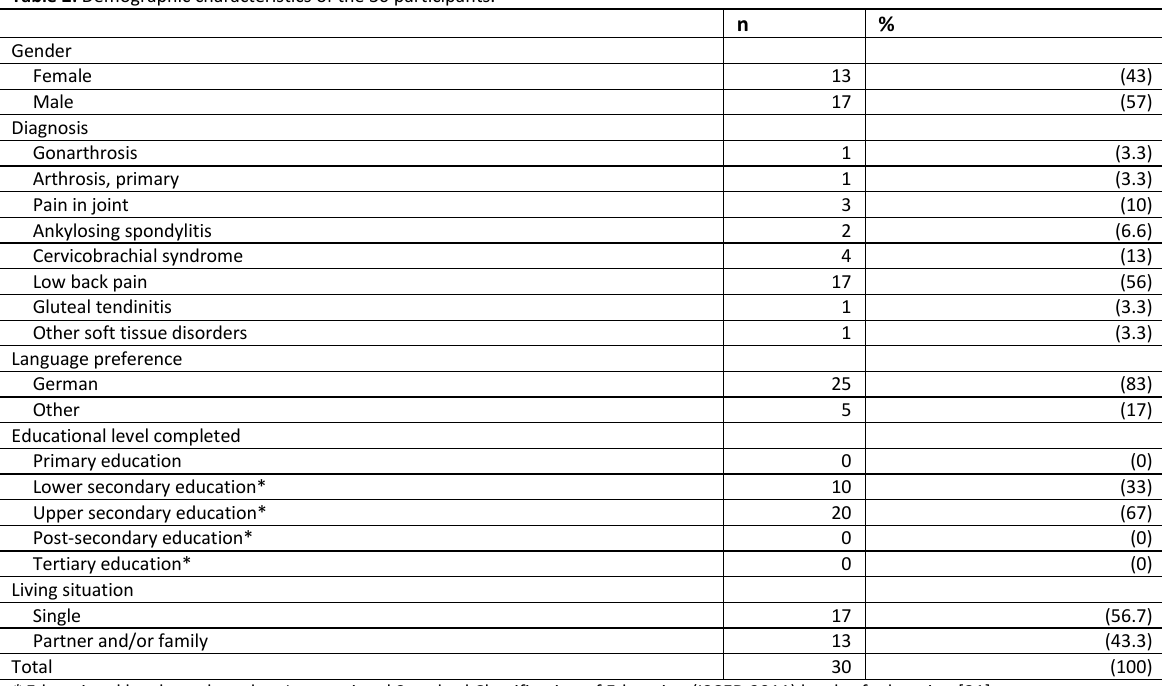
Table 2: Demographic characteristics of the 30